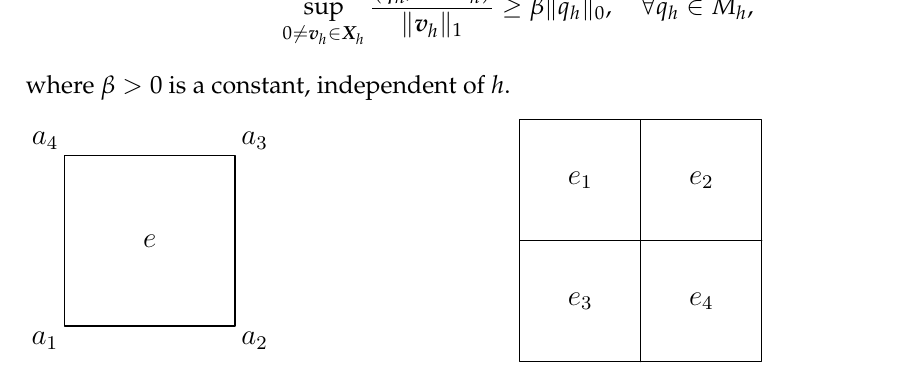
Figure 1. The element e ( left ) and ˜ e ( right